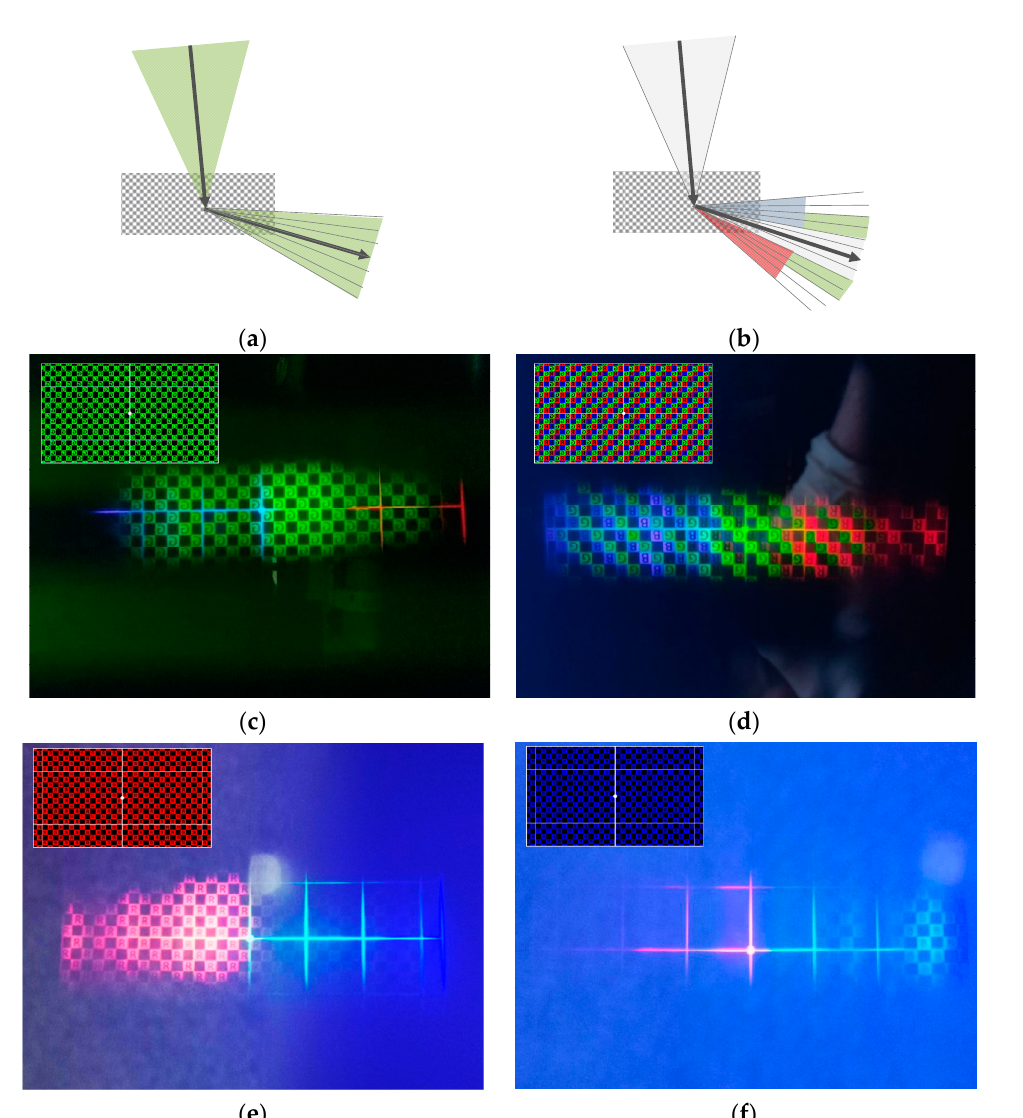
Figure 6. Prototype: ( a ) appearance; ( b ) illustration of the waveguide transparency; ( c ) illustration of augmented information added to the real view.